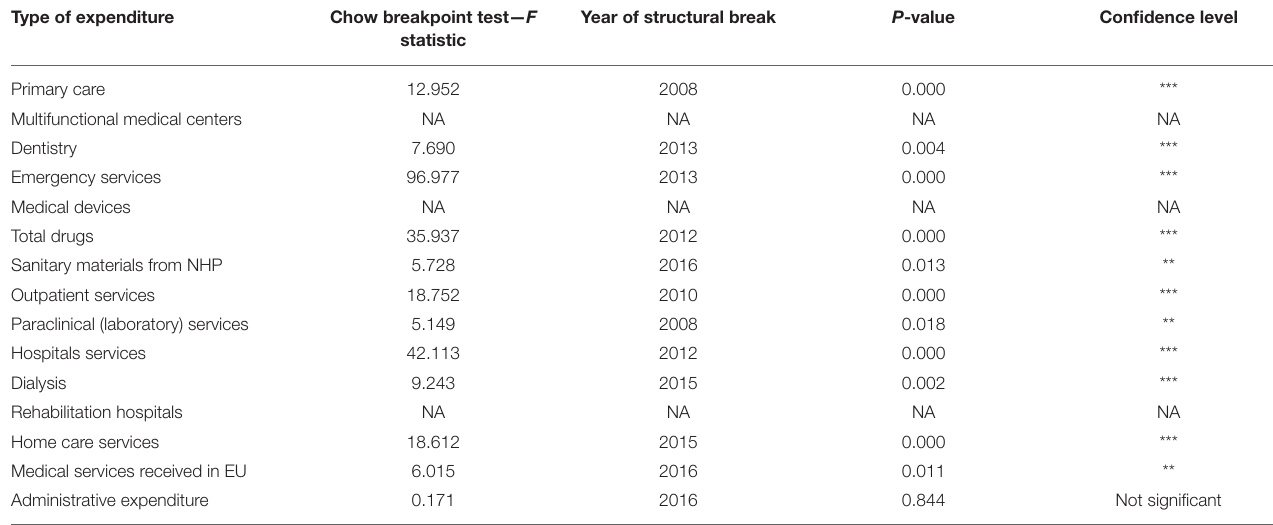
TABLE 3 | Chow breakpoint test results for the trends in different types of expenditure,